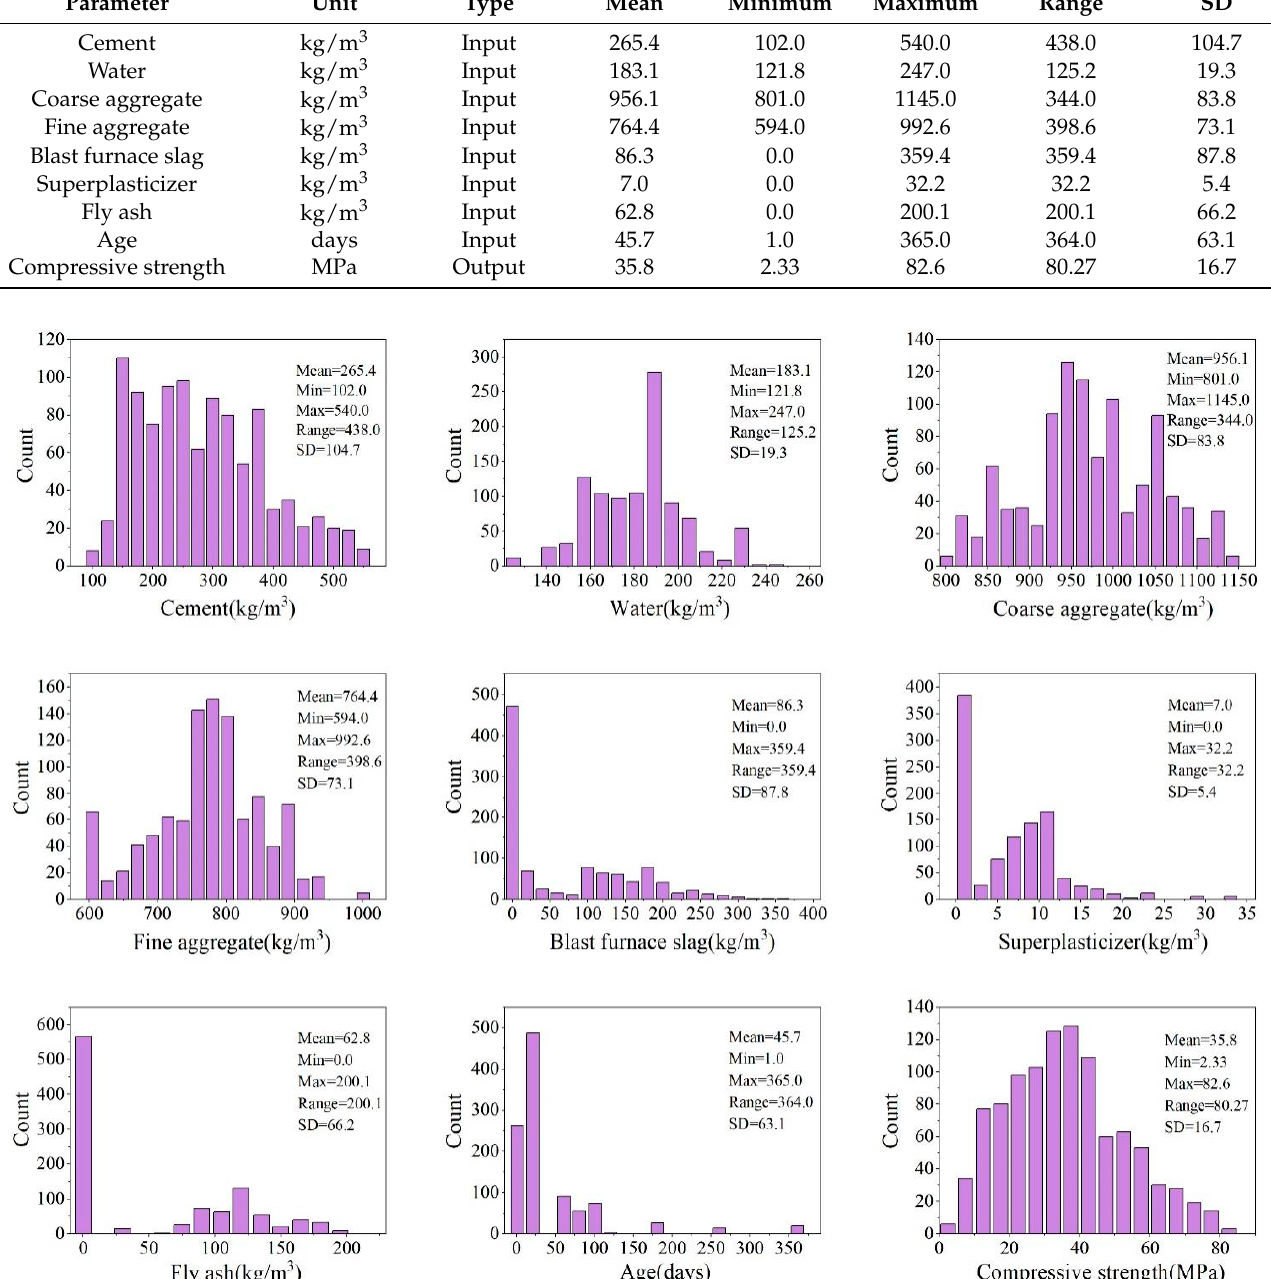
Table 1. The statistical analysis in the compressive strength tests.